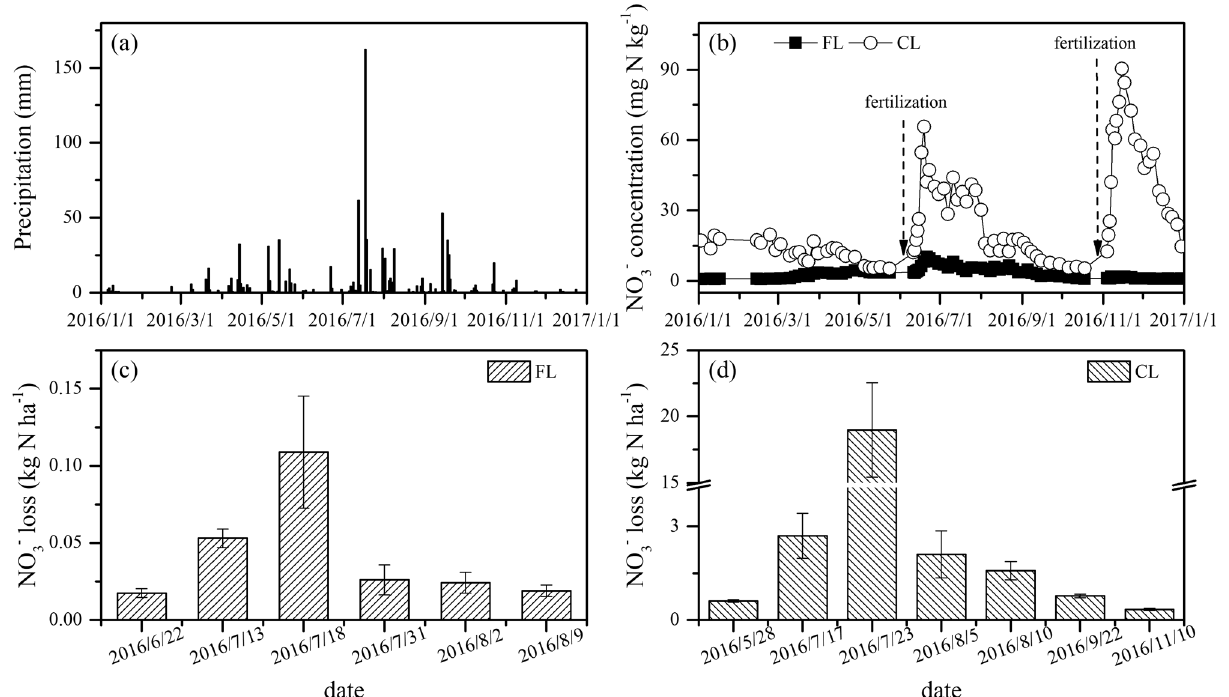
Figure 6. Dynamics of daily precipitation ( a ) and soil NO 3 − concentration ( b ), and soil NO 3 − losses at each runoff event from forestland ( c ) and cropland ( d ) during 2016. FL forestland, CL classification) (mean 3.67 and 3.52 mg N kg −1 day −1 , respectively) 4,34 . But they were higher than those measured in subtropical acidic Regosols of southwest China (mean 1.23 mg N kg −1 day −1 ) 35 . This difference is most likely gross NH 4 + immobilization rates in the forestland soils (mean 6.72 ± 0.74 mg N kg −1 day −1 ) were higher than those